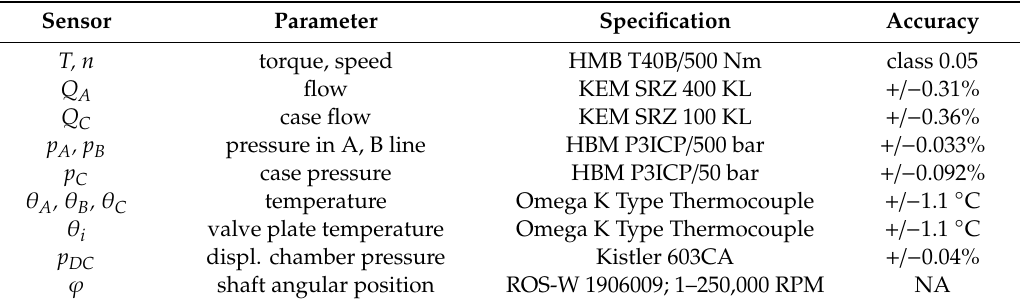
Table 2. Steady-state measurement sensors.